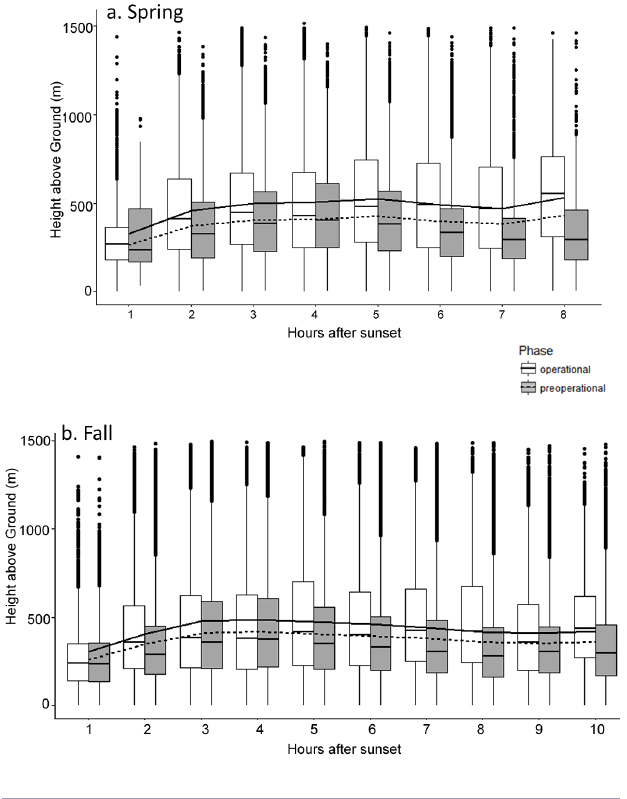
Fig. 4 . Variation in the distribution of altitudes of nocturnal migrants by hour of night (standardized as hours after sunset) during the preoperational phase (2008–2010) and operational phases (2011–2012) in spring (a) and fall (b) at the Dokie I Wind Energy Project in northeast British Columbia. Heights during the operational period (white boxes and solid line) were significantly higher than heights recorded during the preoperational period (grey boxes and dashed lines) in both seasons. Lines represent the smoothed approximations from a general additive model on changes in height in relation to hours of migration. Length of the dawn-dusk period is two hours greater in fall than spring migratory period at the site.